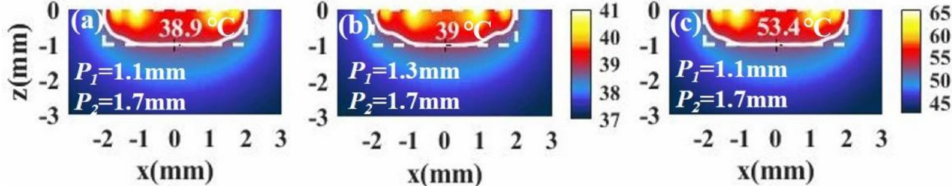
Figure 9. ( a , b ) The temperature distributions of a tumor and the surroundings with I = 15 × 10 4 W/cm 2 and different positions of the inner spot P 1 and the outer spot P 2 in the case of tumor aspect ratio z/ RT = 0.5 ( R T = 2 mm, z = 1 mm). ( c ) The temperature distribution in the case of P 1 = 1.1 mm and P 2 = 1.7 mm with I = 90 W/cm 2